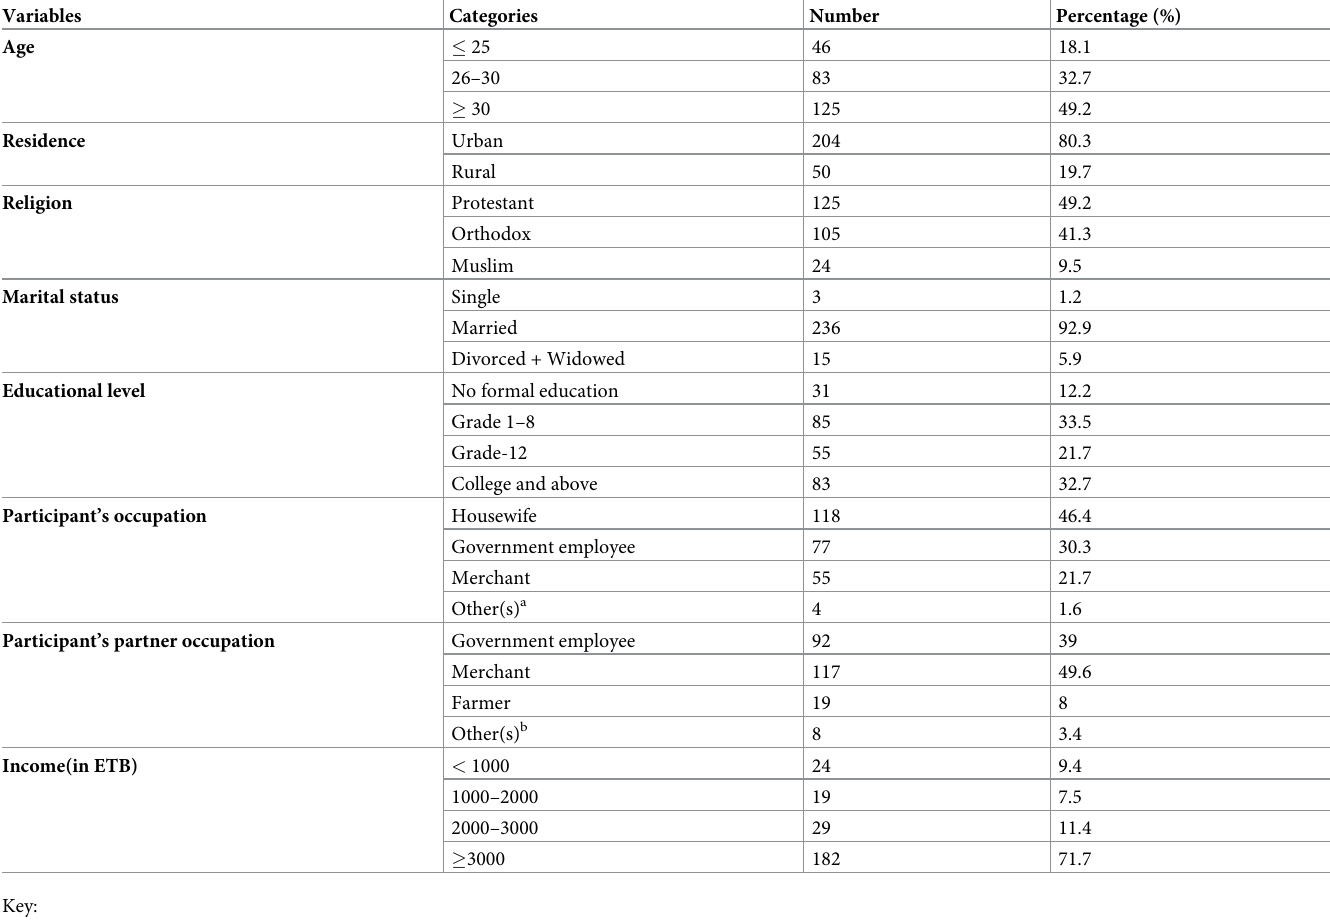
Table 1. Socio-demographic characteristics of participants among HIV+ pregnant & lactating women in pregnant & lactating mothers in selected governmental health facilities of Hawassa city, Southern Ethiopia, 2019/20